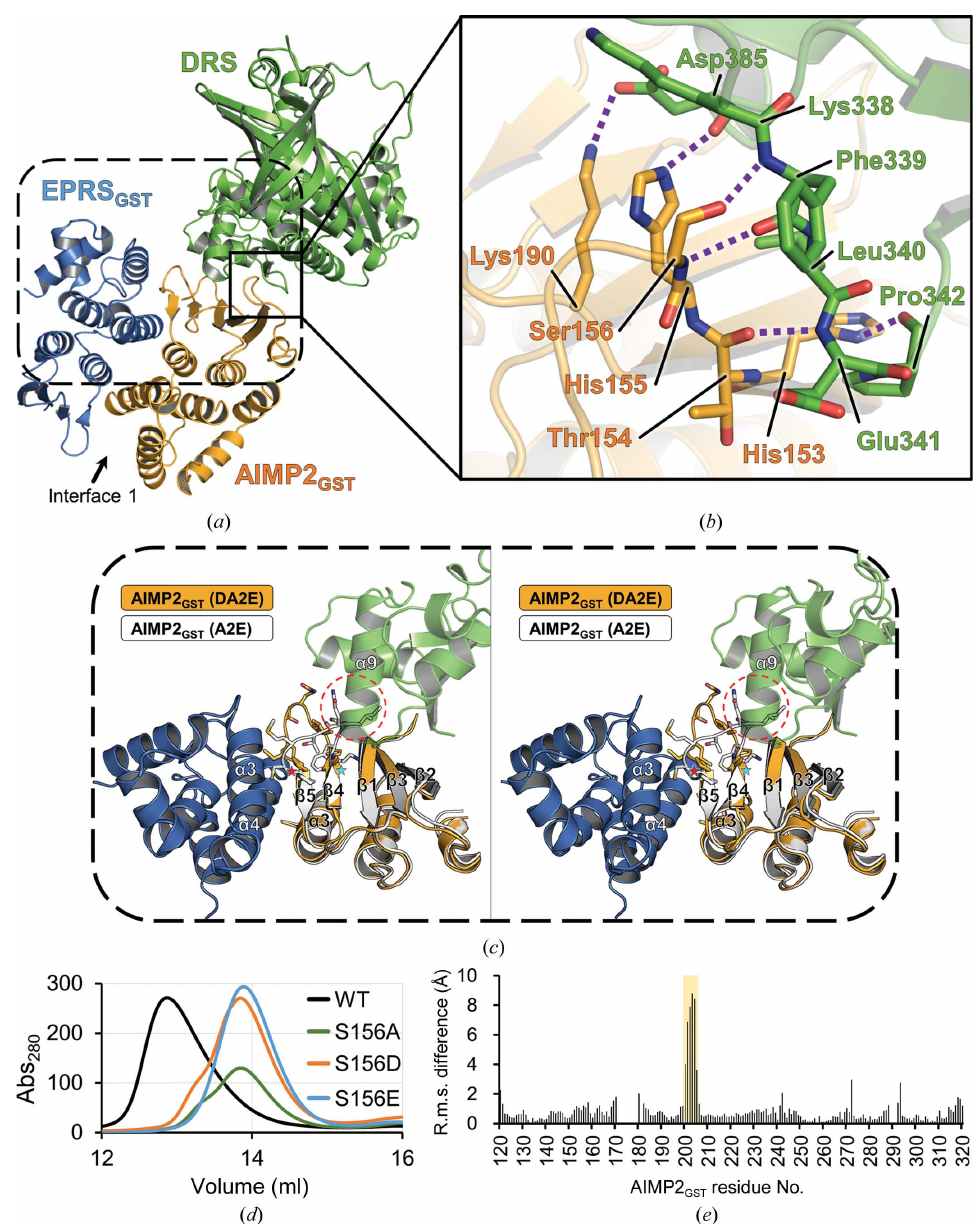
Figure 2 Interfaces among the components of the DA2E subcomplex. ( a ) Overall view of the DA2E structure showing the interfaces between DRS and AIMP2 GST and between AIMP2 GST and EPRS GST . ( b ) Close-up view of interactions between DRS (green) and AIMP2 GST (orange). Hydrogen bonds and salt bridges between DRS and AIMP2 GST are indicated by purple dashed lines. ( c ) Stereoscopic representation showing the effect of DRS incorporation on the AIMP2 GST –EPRS GST interface. The AIMP2 GST structure from A2E (PDB entry 5a34; white) was superposed onto the DA2E structure (orange) to show conformational change in the (cid:3) 4– (cid:3) 5 loop. The (cid:3) 4– (cid:3) 5 loop region of AIMP2 GST from the A2E subcomplex (red circle) collides with helix (cid:2) 9 of DRS shown in transparent cartoon representation (green). The first and the last residues of the (cid:3) 4– (cid:3) 5 loop (Lys198 and Pro206) are marked with cyan and red stars, respectively. ( d ) Size-exclusion chromatography analyses of Ser156 mutants on DA2 complex formation. ( e ) R.m.s.d. analysis of AIMP2 GST structures in DA2E and the heterodimeric complex, showing remarkably large differences in the structures at the (cid:3) 4– (cid:3) 5 loop (Lys198–Pro206), highlighted in a yellow